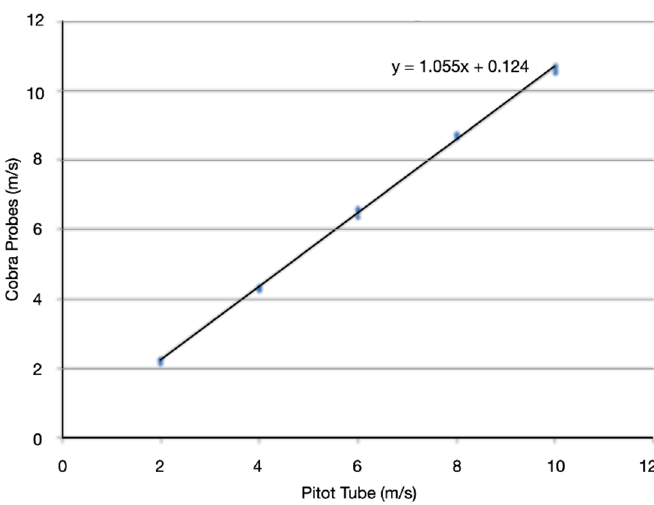
Figure 5. The measurement tools for building models in a wind tunnel are ( a ) cobra probes, ( b ) pitot tubes. ( c ) A demonstration on how to arrange the tools in a wind tunnel.